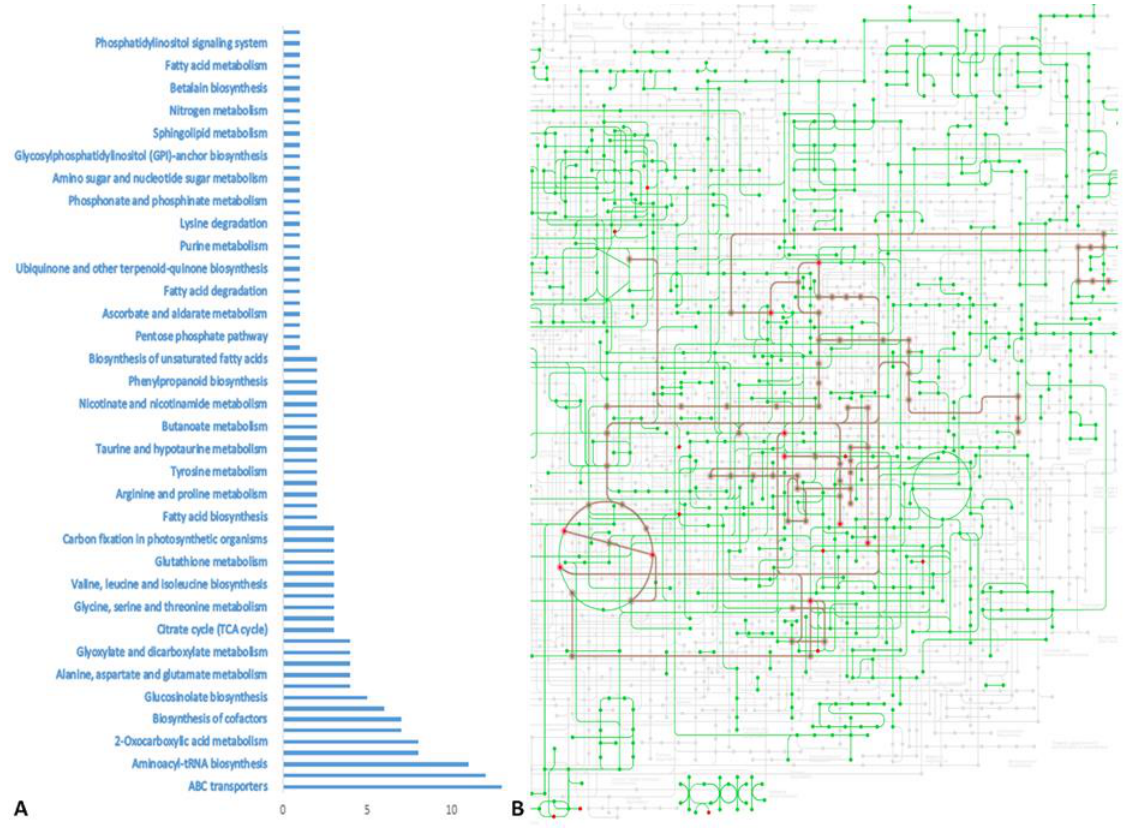
Figure 1. Pathway analysis. ( A ) KEGG list with enriched pathways. Bars for each pathway repre- sented the number matched metabolites. ( B ) Visualization of KEGG metabolic pathways (green) and matched metabolites (red nodes). With red are highlighted the pathways with more than 3 matched queries.